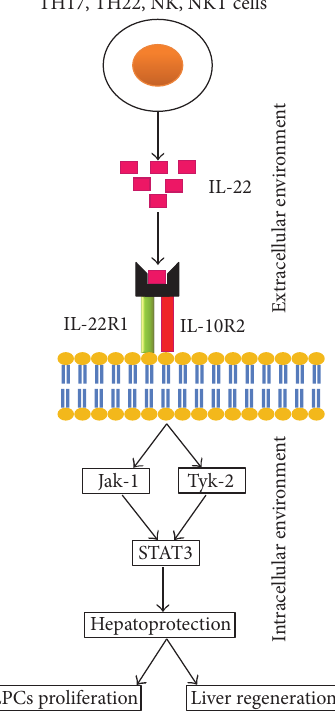
Figure 1: Sources of IL-22 and possible mechanism of action in hepatoprotection. IL-22 is secreted by activated TH17, TH22, NK, and NKT cells and binds to IL-22R complex (IL-22R1 and IL-10R2) and leads to the signal transduction through JAK-STAT pathway which may involve Jak-1, Tyk-2, and STAT3. STAT3 activation results in hepatoprotection and liver regeneration.